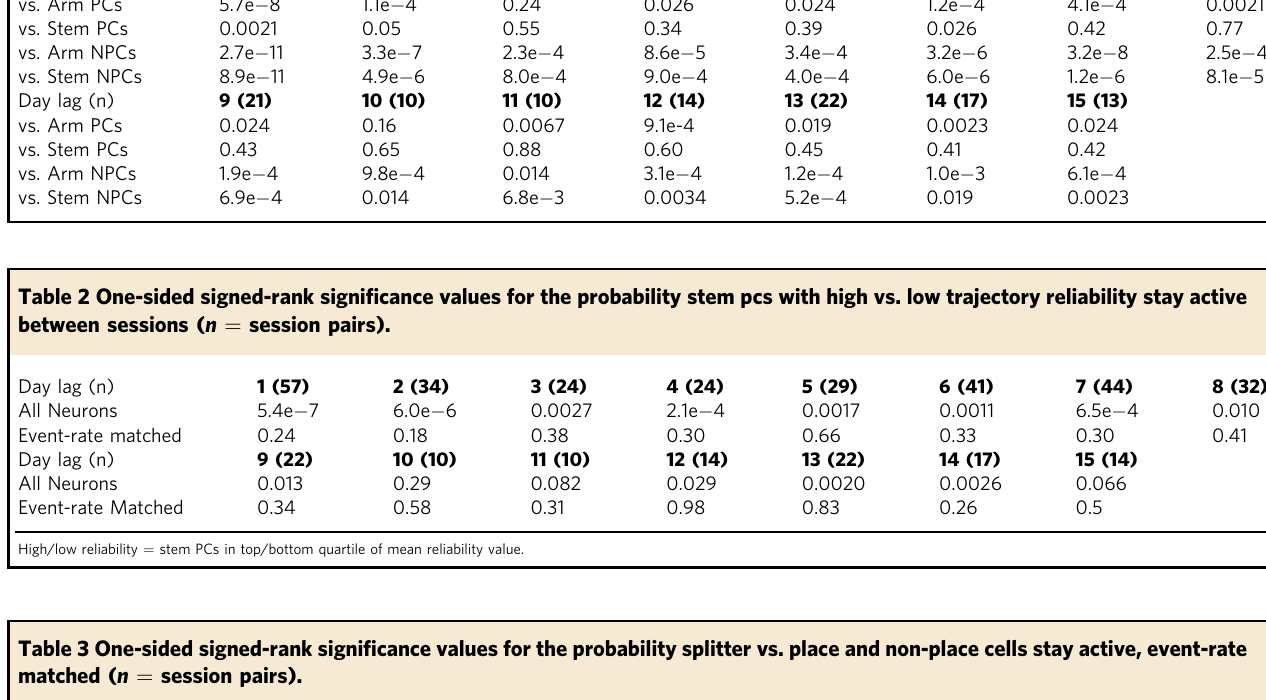
Table 1 One-sided signed-rank signi fi cance values for the probability splitter vs. place cells (PCs) and non-place cells (NPCs) remain active between sessions ( n = session pairs).